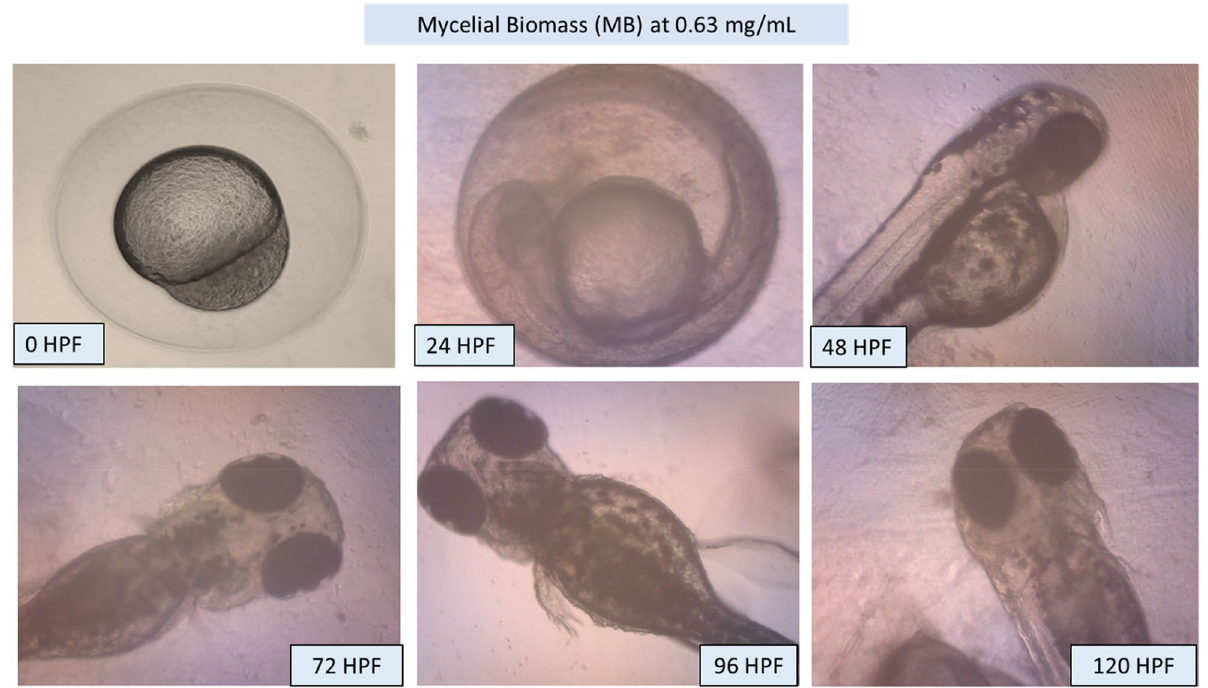
Figure 6. Illustrations of zebrafish embryo and larvae development after treated with Tiger Milk mushroom Lignosus rhinocerus strain ABI at EPS concentration of 0.63 mg/mL. Descriptions were captured using an